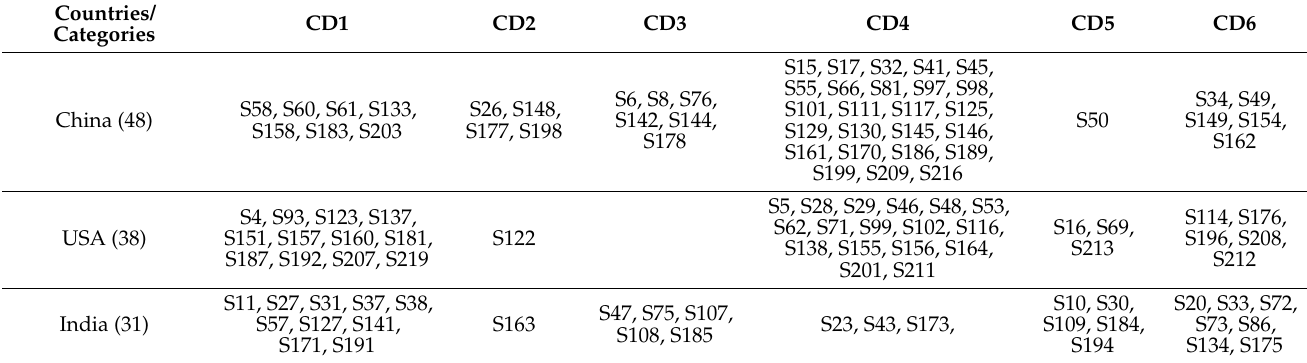
Table A5. Publications distributed by countries and application domain